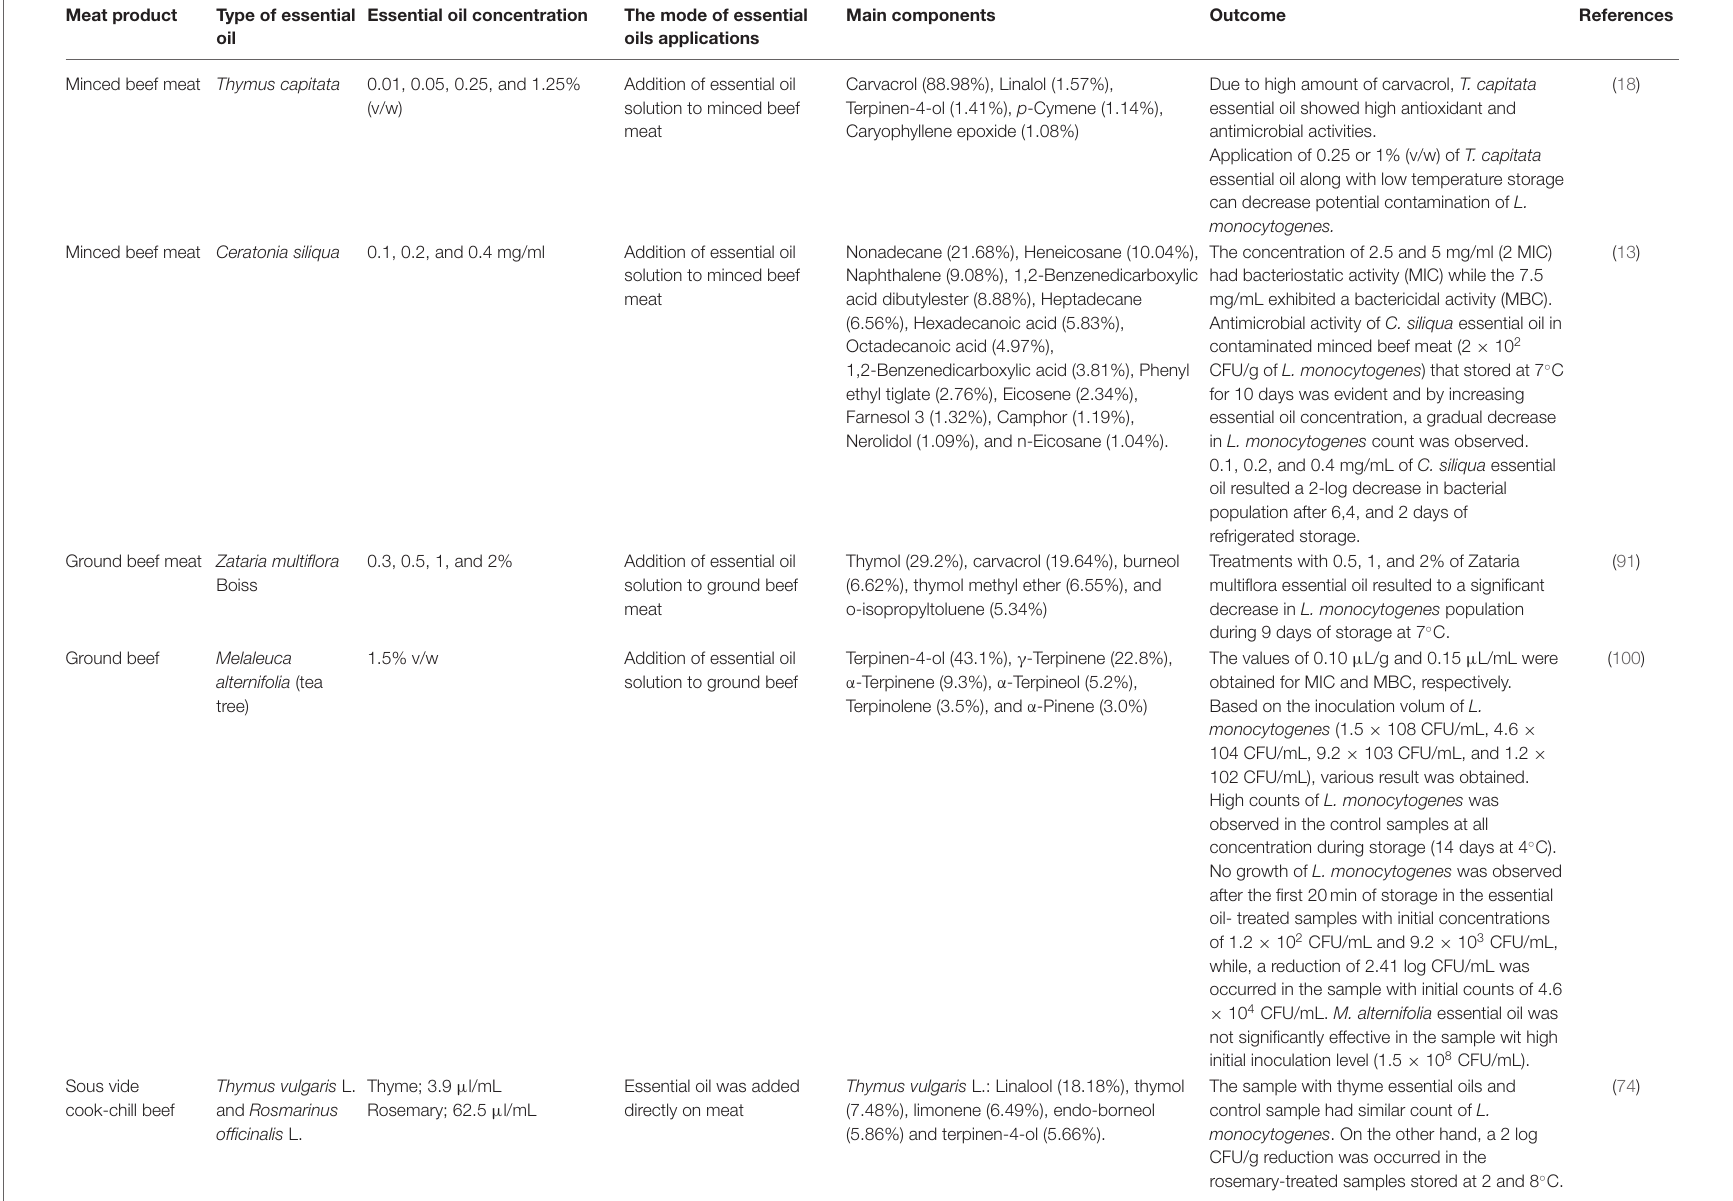
TABLE 1 | Major compounds of essential oils utilized in meat and poultry products against Listeria monocytogenes